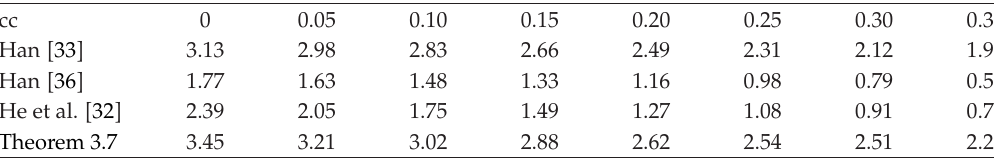
Table 5: Comparison of τ max using di ff erent methods (cid:2) Example 4.4 (cid:3)